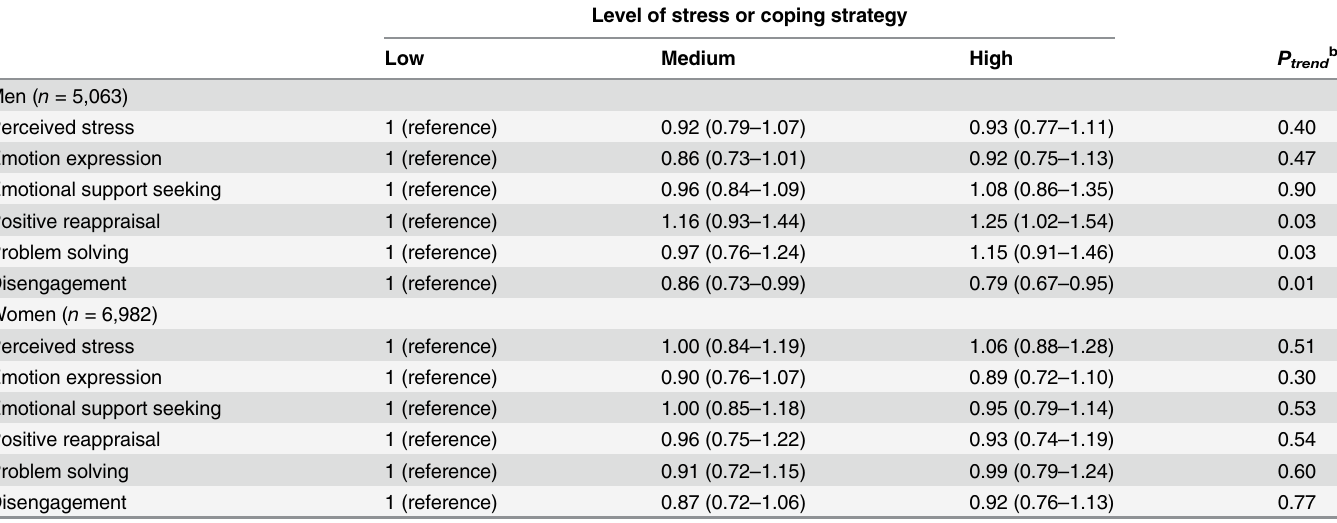
Table 5. Adjusted odds ratios a (and 95% con fi dence intervals) of overweight/obesity (body mass index (cid:1) 25 kg/m 2 ) for each of perceived stress and coping strategies by gender — Japan, 2005 –